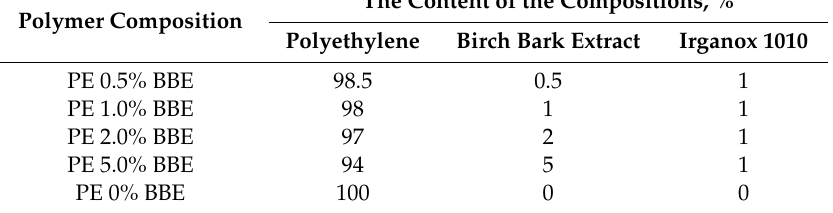
Table 3. Component composition of polymeric compositions based on polyethylene (PE) with birch bark extract (BBE).